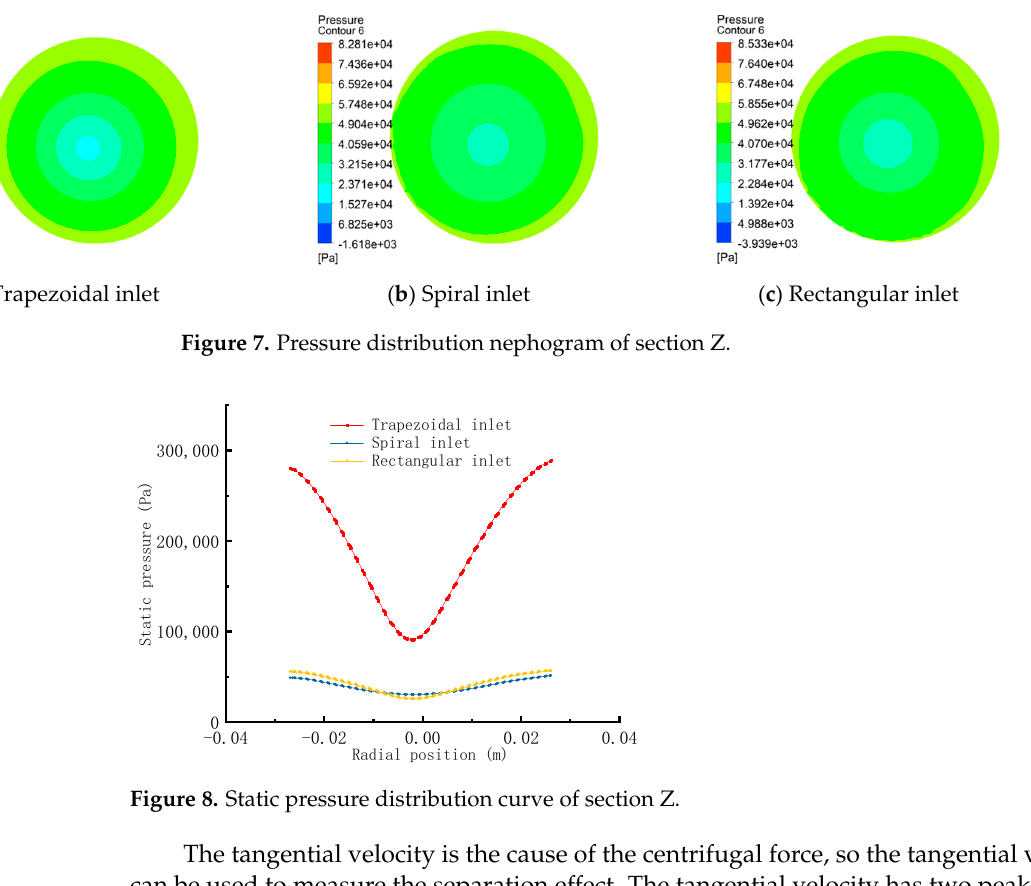
Figure 6. Distribution of bubble motion in longitudinal section.